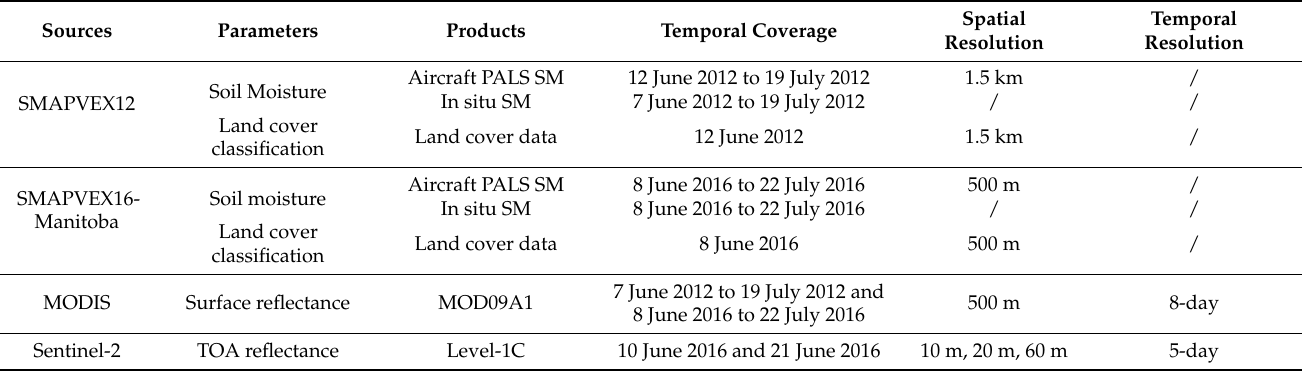
Table 1. Materials used in this study.